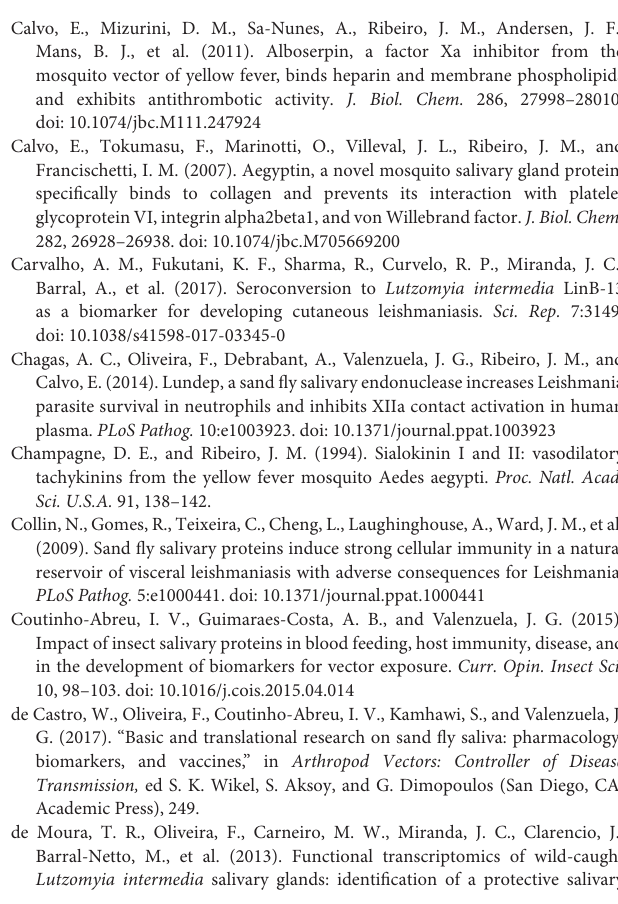
the Phlebotomus and Paraphlebotomus subgenera; and Black color indicates the proteins belonging to New World sand flies. Supplementary Figure 13 | Multiple sequence alignment and molecular phylogenetic analysis of the sand fly Yellow salivary protein family. (Top) Multiple sequence alignment of Yellow . PPTSP42 and PPTSP44 ( P. papatasi ), PduK06 and PduM10 ( P. duboscqi ), PsSP22 and PsSP26 ( P. sergenti ), ParSP04 and ParSP04b ( P. ariasi ), PorASP2 and PorASP4 ( P. orientalis ), PtSP37 and PtSP38 ( P. tobbi ), PpeSP03B and PpeSP03 ( P. perniciosus ), PkanSP04 ( P. kandelakki ), PabSP26 ( P. arabicus ), PagSP04 ( P. argentipes ), LolYLWb and LolTLWc and LolYLWA ( B. olmeca ), Linb-21 ( N. intermedia ), LayS22 and LayS118 ( Lu. ayacuchensis ), and LJM17 and LJM17 and LJM111 ( Lu. longipalpis ). Black background shading represents identical amino acids. Gray background shading represents similar amino acids. Asterisks indicate the conserved cysteine residues. (Bottom) The evolutionary history of Yellow salivary protein family was inferred by using the Maximum Likelihood method based on the Whelan And Goldman model (Whelan and Goldman, 2001). Sand fly species are indicated by the different symbols in the legend on the right. Tree branches were color-coded so as to represent specific taxon: Green color represents the Larroussius and Adlerius subgenera; Red color indicates the Euphlebotomus subgenus; Blue color points to proteins of the Phlebotomus and Paraphlebotomus subgenera; and Black color indicates the proteins belonging to New World sand flies. Names in bold represent 44 kDa protein homologs. Supplementary Figure 14 | Multiple sequence alignment of the sand fly Adenosine deaminase salivary protein family. PduM73 ( P. duboscqi ), PpeAda ( P. perniciosus ), and LJLAda ( L. longipalpis ). Black background shading represents identical amino acids. Gray background shading represents similar amino acids.